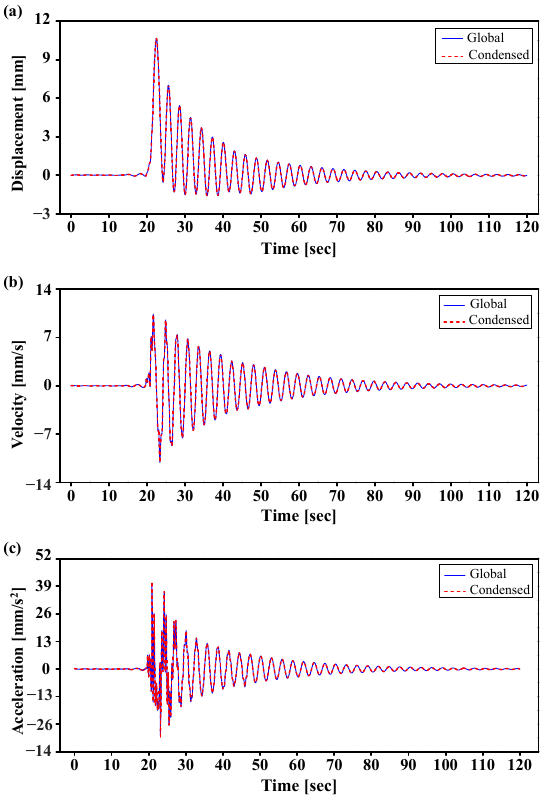
Figure 11. Transient analysis results for #1 node: ( a ) Displacement, ( b ) Velocity, and ( c ) Acceleration.